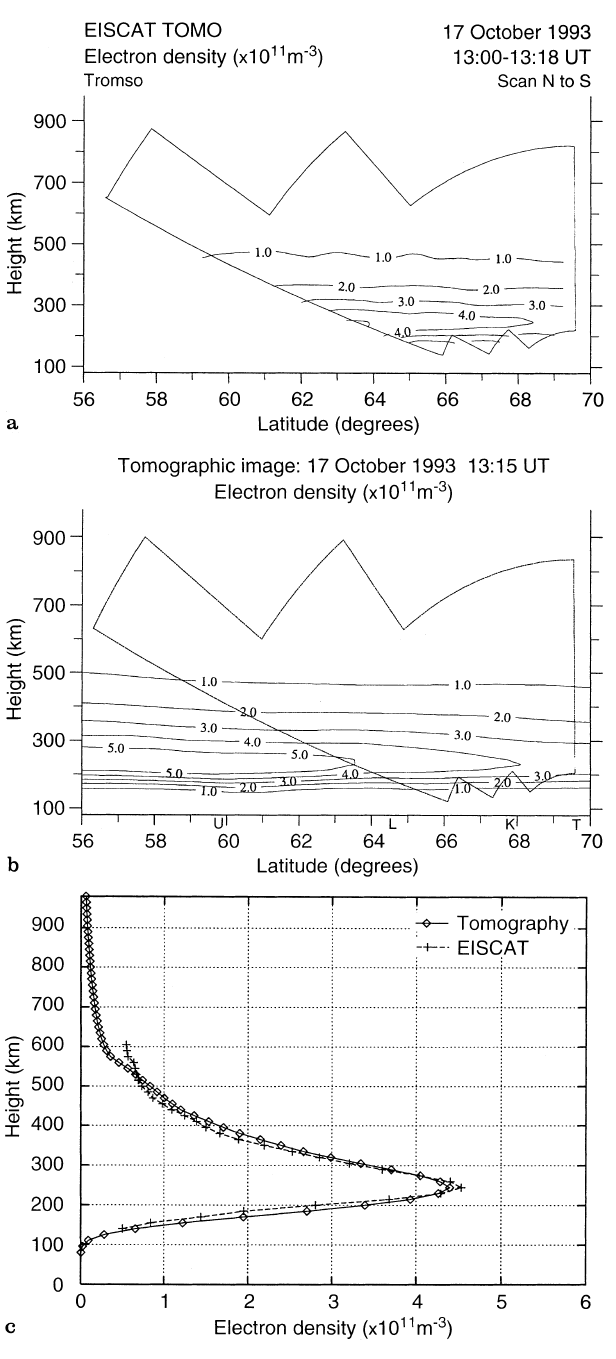
Fig. 3. a EISCAT SP-UK TOMO data from 13:00 to 13:18 UT, b tomographic image for a satellite pass at 13:15 UT on 17 October 1993 and c profiles through the images at 66 (cid:176) N